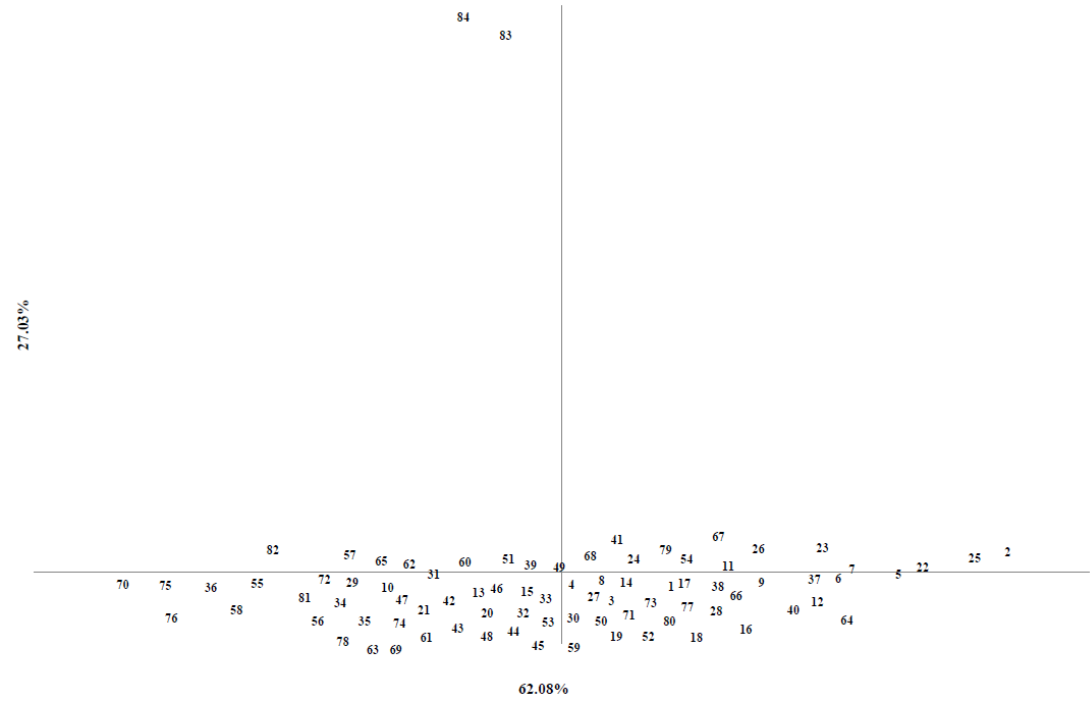
Figure 3. Results of Principal Component Analysis based on mitochondrial and chloroplast haplotypes in the study populations of Abies alba. The population codes are shown in Table 1.